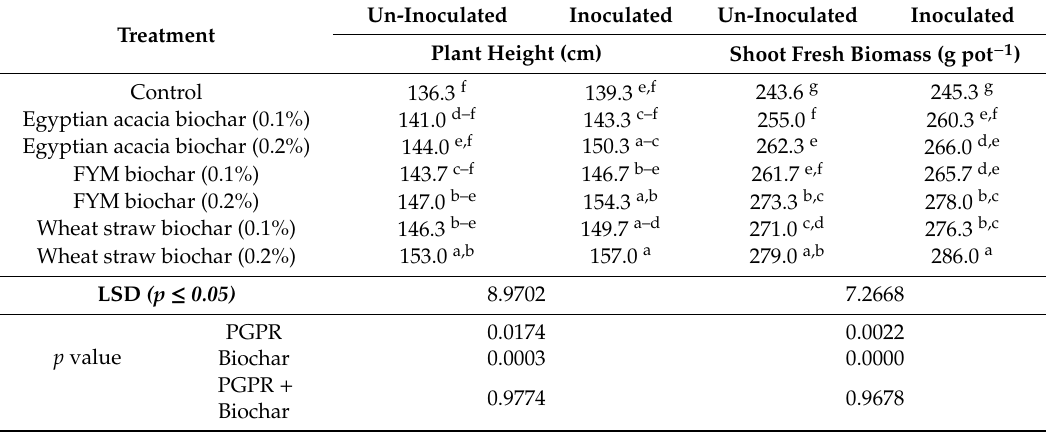
Table 5. E ff ects of biochar with and without Bacillus sp. ZM20 on plant height, shoot fresh biomass, shoot dry biomass, and 1000-grain weight of maize in field